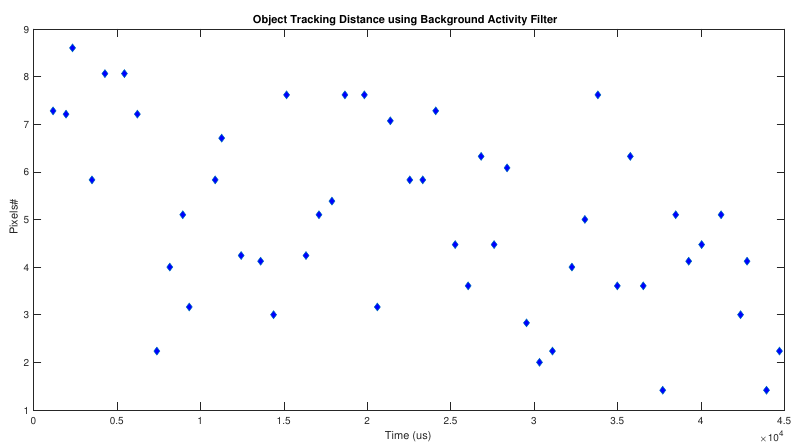
Figure 15. Error values in object tracking (actual position vs. tracking algorithm position) when the jAER built-in background activity filter is